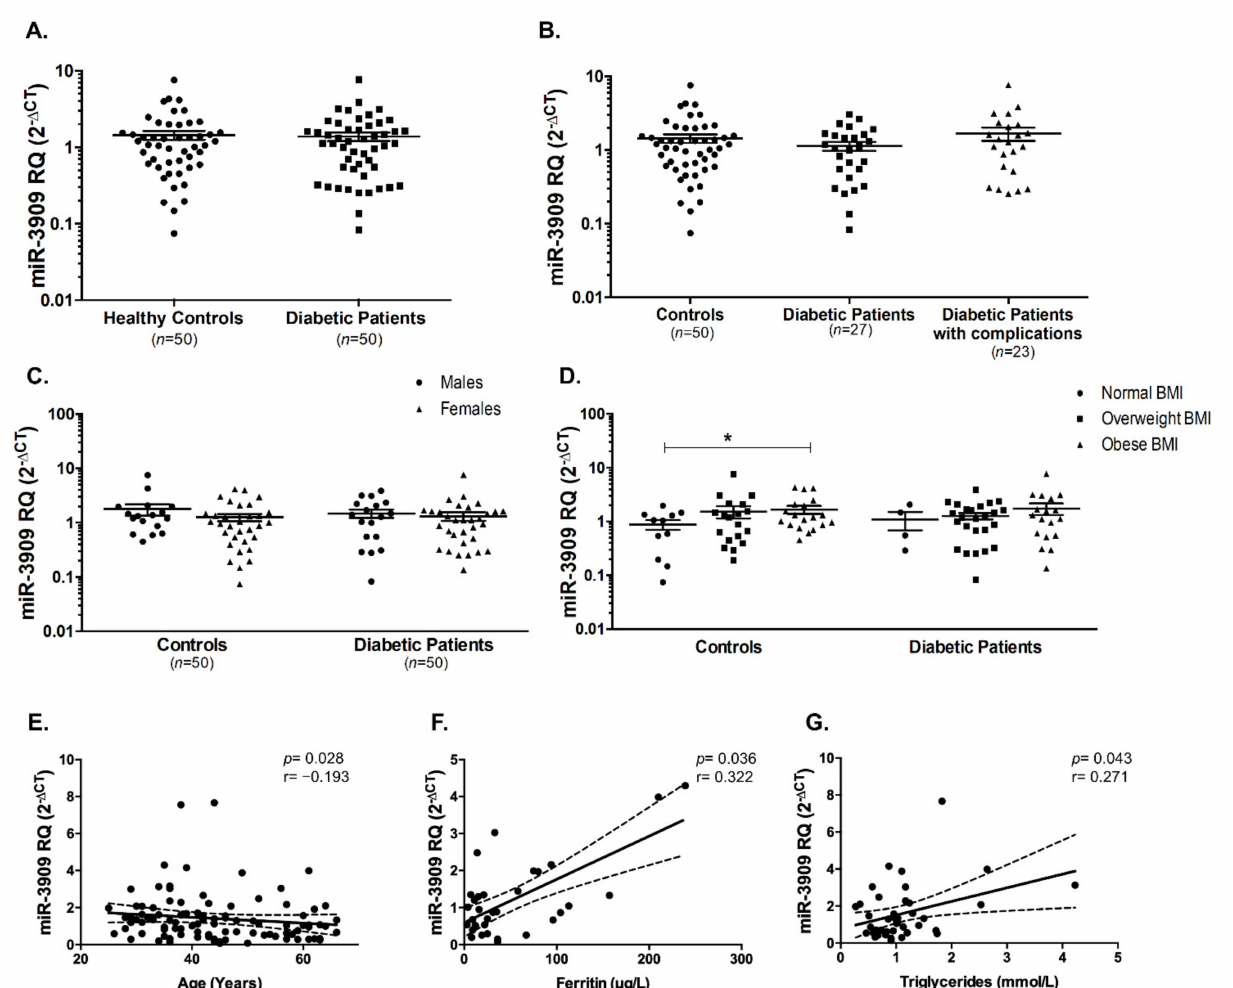
Figure 3. miR-3909 was unaltered in T2DM patients compared to healthy controls. ( A ) miR-3909 was not changed in all T2DM patients as well as ( B ) in diabetic patients with or without diabetic complications. ( C ) miR-3909 levels were unaffected by gender in healthy controls and diabetic patients. ( D ) miR-3909 was elevated in obese healthy individuals compared to healthy individuals with normal BMI. There was a significant ( E ) negative correlation between miR-3909 and age, and there were positive correlations between miR-3909 and ( F ) ferritin, and ( G ) triglycerides, respectively. Dashed lines represent 95% confidence intervals. * indicates p <